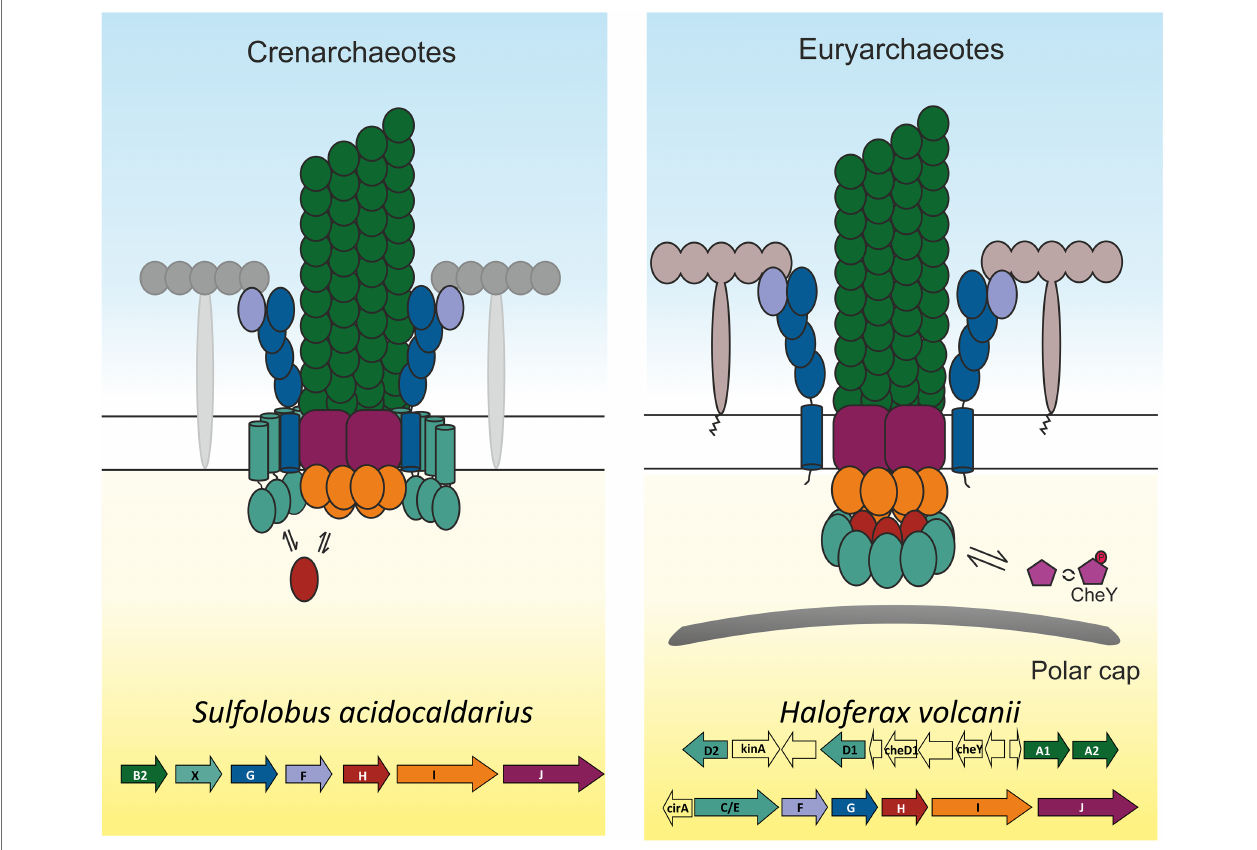
FIGURE 1 | The archaellum machinery in Cren- and Euryarchaeota. The structural proteins of the archaellum are encoded by genes organised in the arl cluster. The arl cluster differs between Crenarchaeota and Euryarchaeota in three main aspects: Crenarchaeota usually encode a single archaellin, with multiple present in the euryarchaeal arl cluster; the order of the genes arlF and arlG is different between the two phyla. The gene arlX is present only in Crenarchaeota and is replaced with arlCDE in Euryarchaeota (Desmond et al., 2007). ArlCDE in Euryarchaeota is thought to be linked to the chemotaxis machinery. ArlCDE is absent in Crenarchaeota, which also lack chemotaxis. The pre-archaellin peptidase PibD/ArlK is also essential for archaella biogenesis, but this gene is frequently found elsewhere in the genome. Upon expression of the cluster, the archaellum motor complex self assembles at the